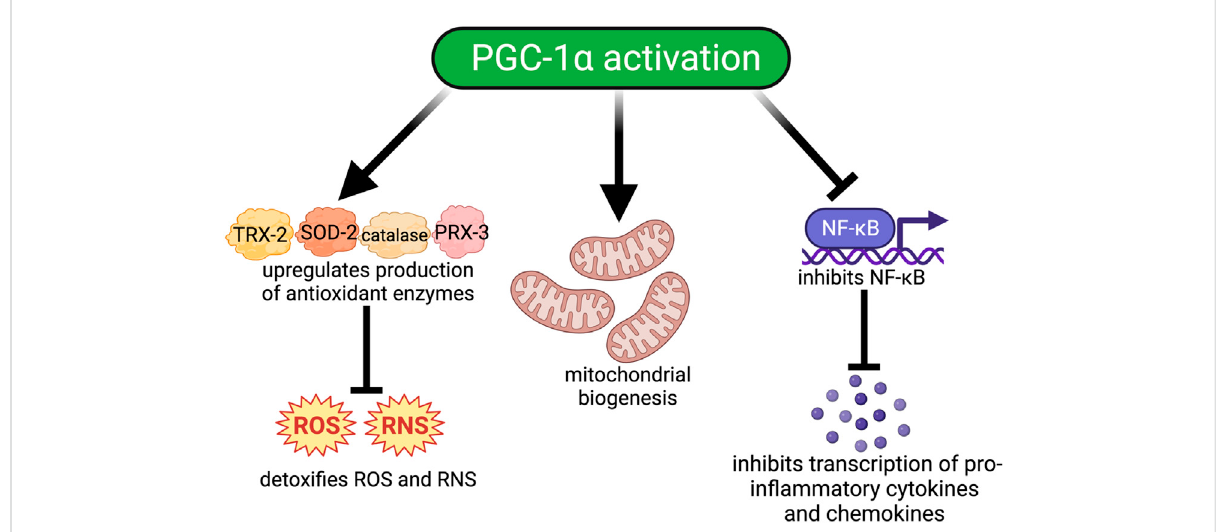
FIGURE 2 Downstream signaling pathways modulated by PGC-1 α activation. Activation of PGC-1 α . 1) improves oxidative injury by increasing the production of antioxidant enzymes such as catalase, thioredoxin-2 (TRX-2), peroxiredoxin-3 (PRX-3), and manganese superoxide dismutase